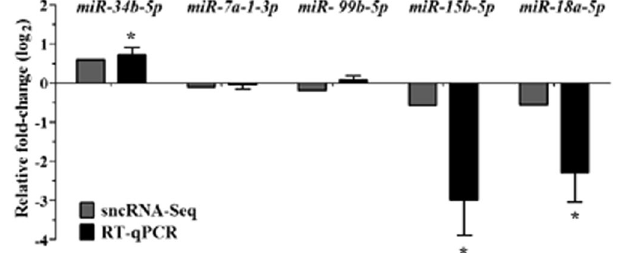
Figure 5. Validation of differentially expressed miRNAs. SncRNA-Seq (gray bars) and RT-qPCR (black bars) of selected mature miRNAs expression in mice testes exposed to the mixture of EDCs vs control mice. DESeq normalised values for sncRNA-Seq and fold change (log 2 ) for both sncRNA-Seq and TaqMan RT-qPCR in relation with miRNA expression of control mice ± SEM, n = 4, Mann–Whitney U test, * p <